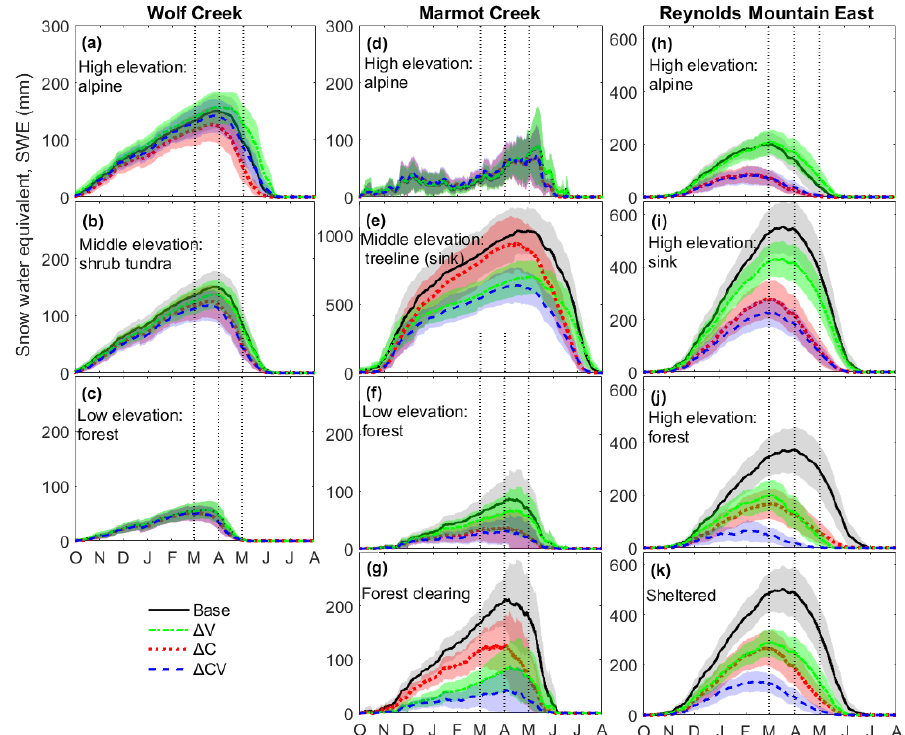
Figure 6. Simulated snowpack accumulation and ablation under current climate and vegetation (base scenario) and changes due to climate and vegetation changes at different elevation levels and in current biomes in the Wolf Creek Research Basin, the Marmot Creek Research Basin, and Reynolds Mountain. Reynolds Mountain only has one elevation band but multiple blowing snow regimes. The 95% confidence intervals shown by the shaded areas indicate the interannual variability. The three vertical lines denote the first days of March, April, and May,